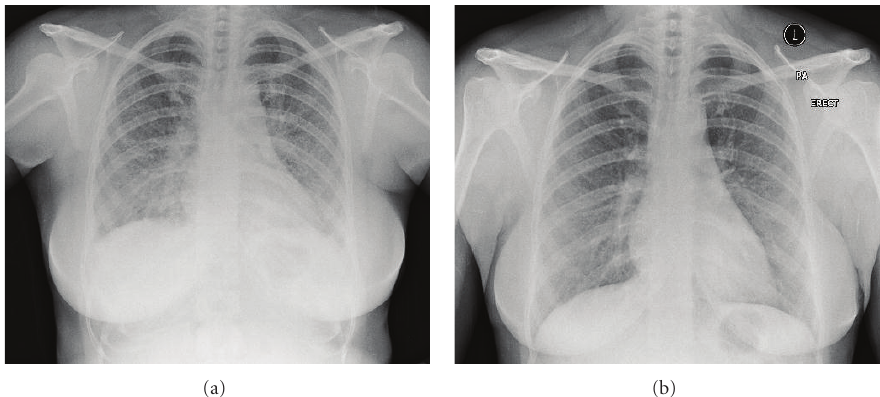
Figure 1: Chest X-ray pre-and postdiscontinuation of anti TNF- α therapy and commencement of oral prednisolone. (a) Chest X-ray with widespread reticulonodular shadowing with prominence of the of right hilum suggestive of lymphadenopathy pre-anti-TNF- α therapy. (b) Chest X-ray showing improvement in the extent of reticulonodular shadowing post-discontinuation of anti-TNF- α therapy and the commencement of oral prednisolone.